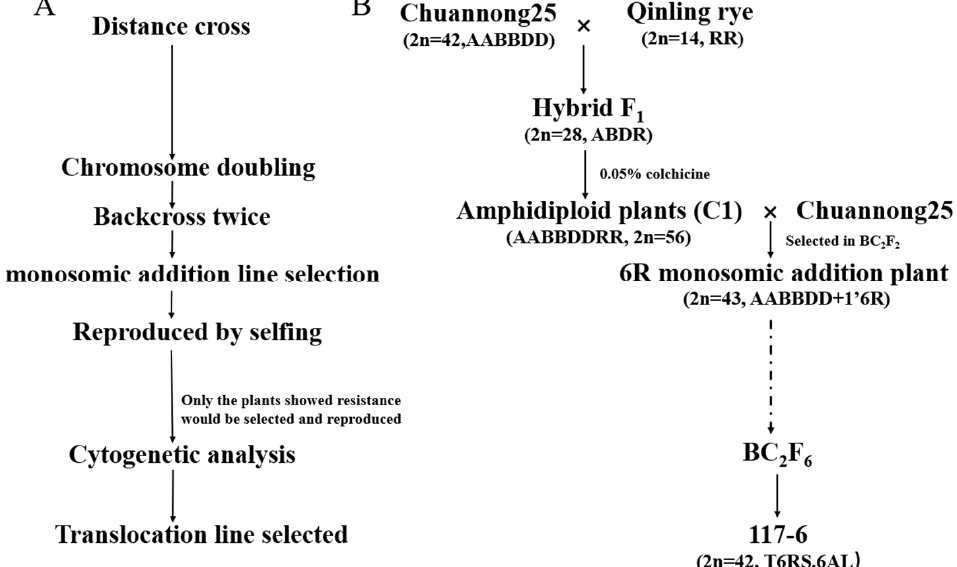
Figure 1. Development of new T6RS.6AL translocations line 117-6. ( A ) The development of the translocation 117-6. ( B ) Pedigree of 117-6 .